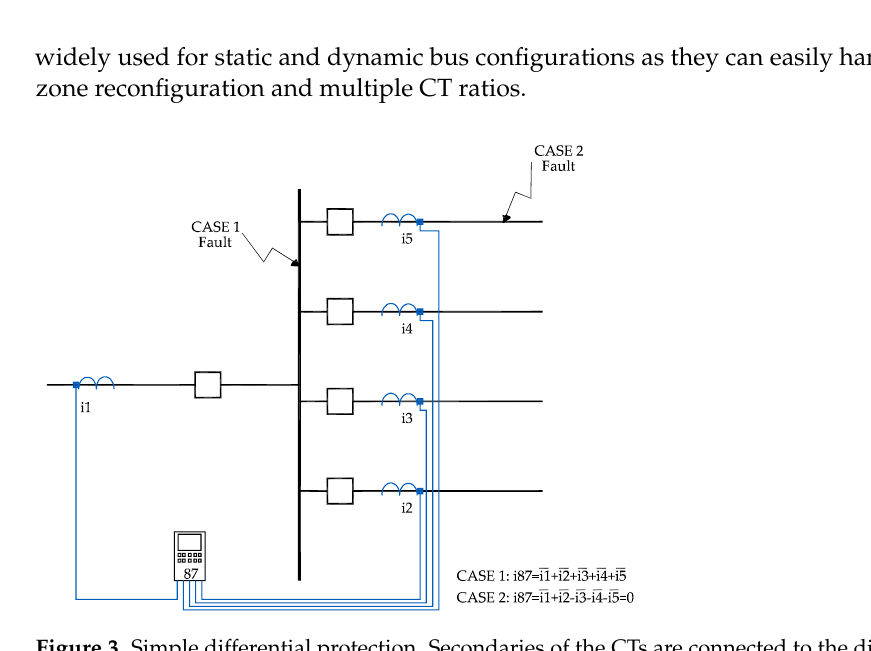
Figure 3. Simple differential protection. Secondaries of the CTs are connected to the differential relay.